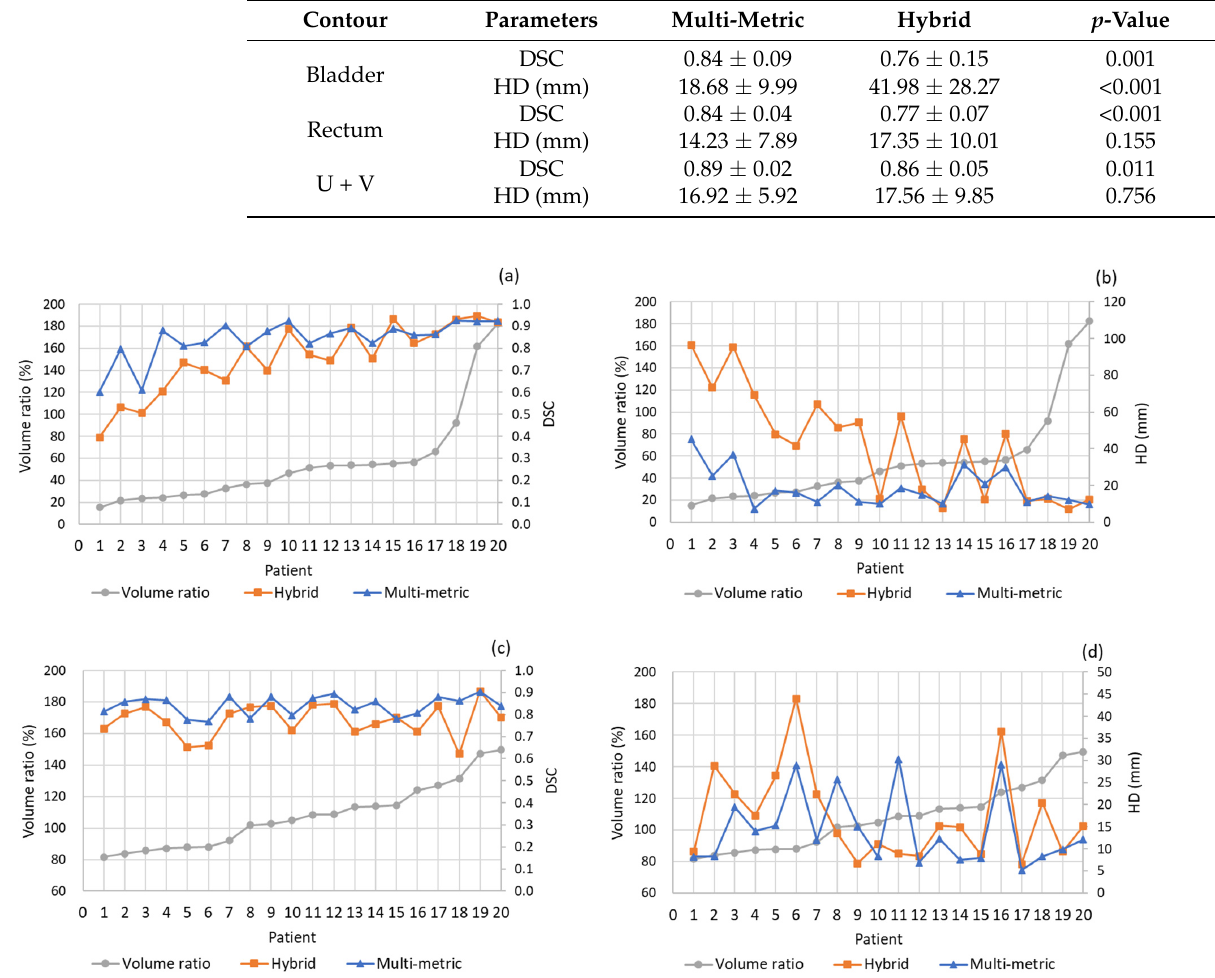
Table 1. DSC and HD of bladder, rectum, and U + V between multi-metric and hybrid DIR (mean ± standard deviation).